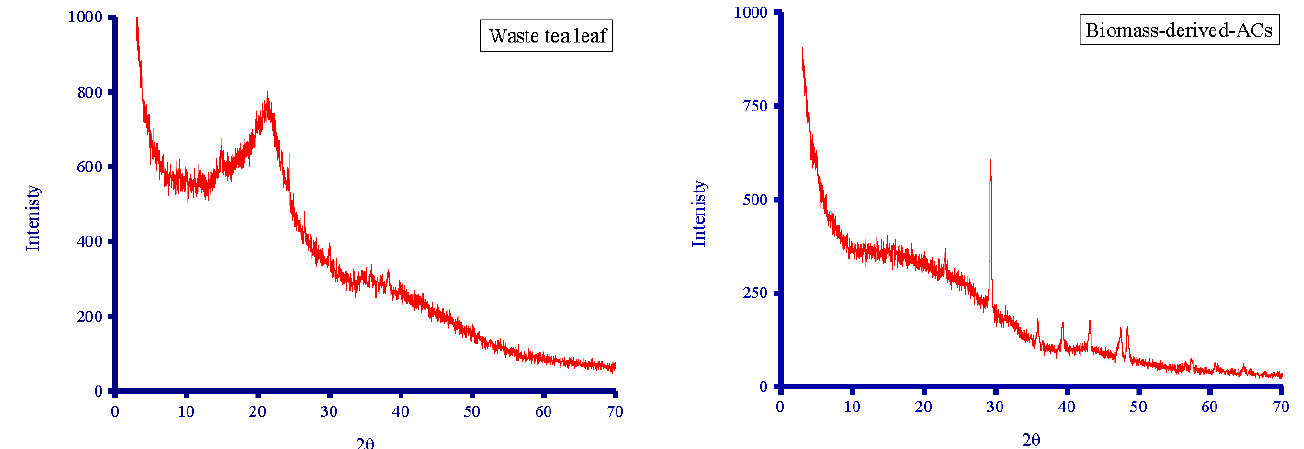
Figure 3. XRD spectra of waste tea leaf, biomass-derived-ACs, and the Fe 3 O 4 -carbon-based compo- site.